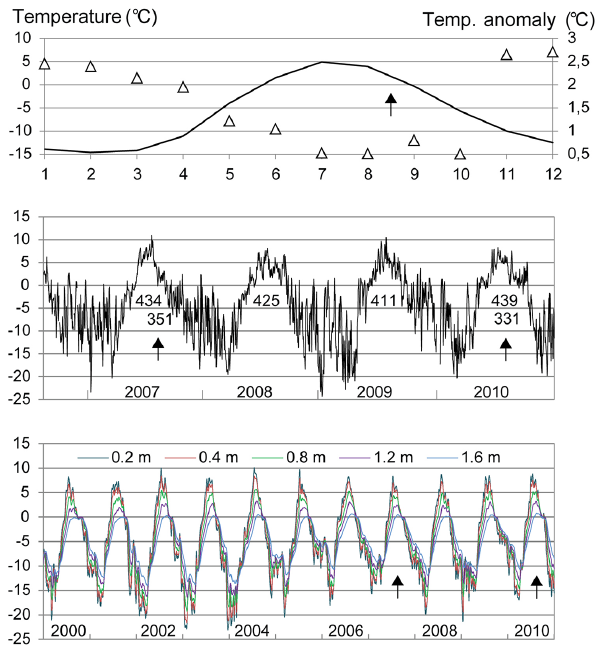
Figure 4. Upper panel: mean monthly air temperature in Ny- Ålesund for the 1961–1990 normal period (solid line). Tempera- ture anomaly for all months calculated as a mean of monthly devia- tions from normal during the 1991–2010 period (triangles). Middle panel: air temperature in Ny-Ålesund during the September 2006– December 2010 period. Degree-day sum during summers of 2007– 2010 displayed within the graph; sum at the time of photography in 2007 and 2010 below. Lower panel: ground temperatures from the shallow Janssonhaugen borehole. Photography dates indicated by arrows. Air temperature data downloaded from eKlima, Norwegian Meteorological Institute. Ground temperature data from K. Isaksen (personal communication, 2013).